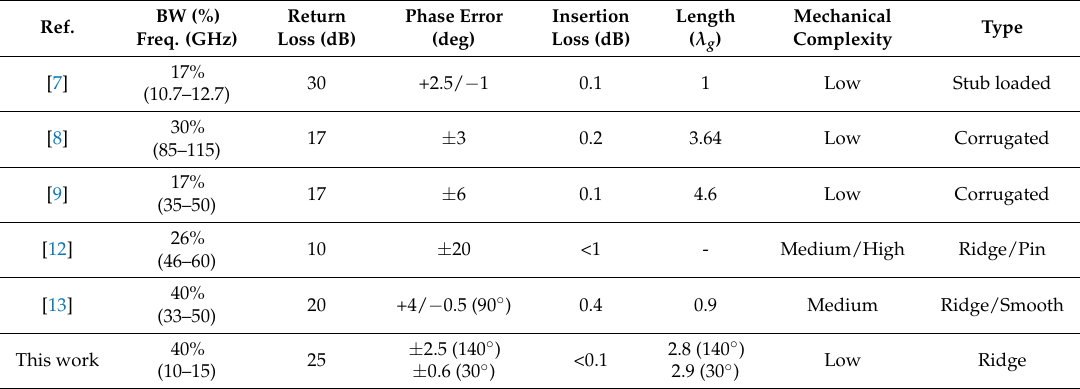
Table 3. Comparison between published results of waveguide